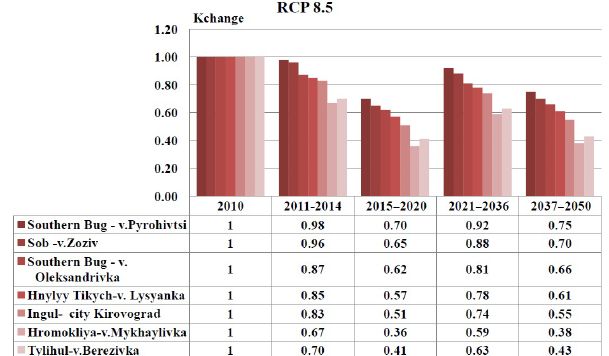
Figure 6. Expected average annual values k ch for taking into ac- count the influence of climate change on the maximal runoff of spring flood of the rivers of the Southern Bug basin using the model RACMO2, scenario RCP8.5